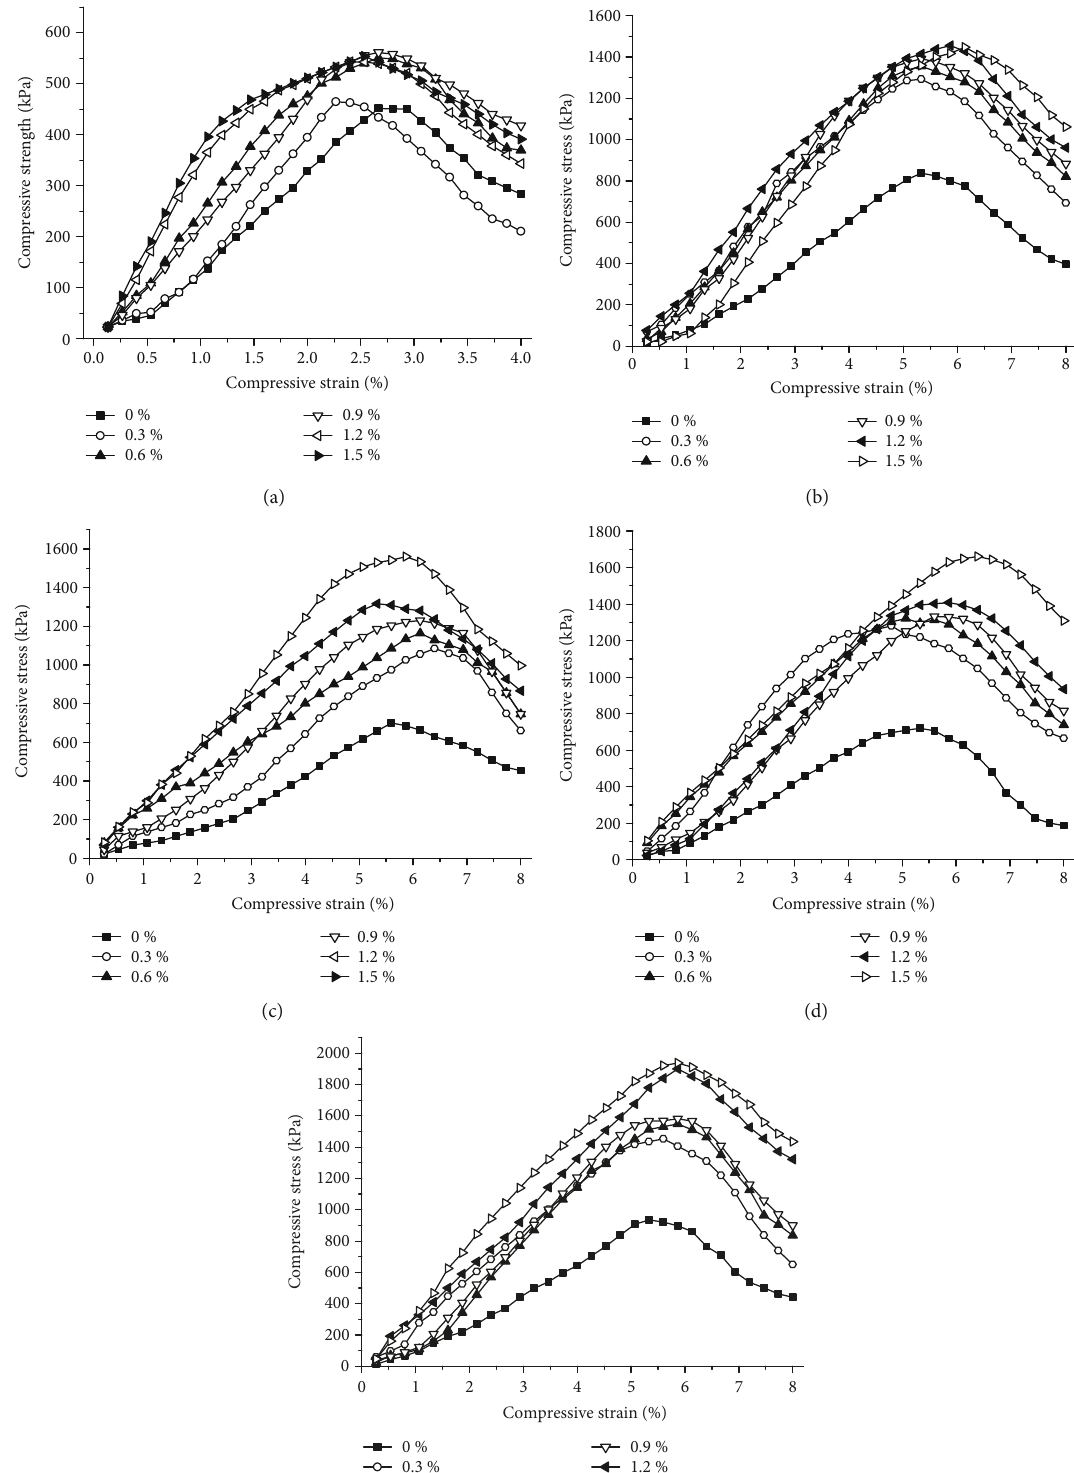
Figure 2: Compressive strength and compressive strain of specimens with di ff erent ZM concentrations after a curing time of (a) 0 d, (b) 7d, (c) 14d, (d) 21 d, and (e) 28